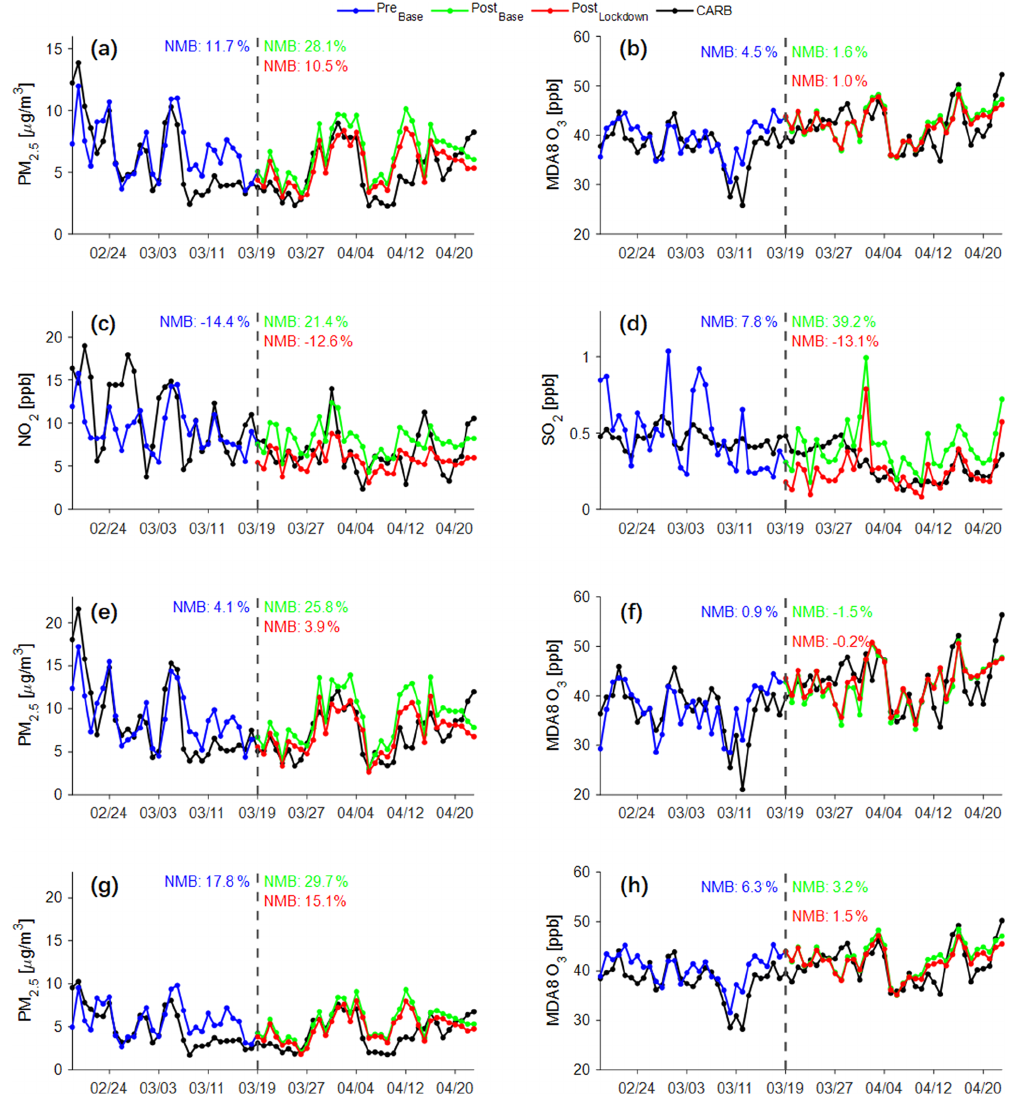
Figure 3. Time series of observed and simulated concentrations of major pollutants. (a–d) Time series of (a) PM 2 . 5 , (b) MDA8 O 3 , (c) NO 2 , and (d) SO 2 averaged across all observational stations from CARB over southern California. (e–f) Time series of (e) PM 2 . 5 and (f) MDA8 O 3 across all stations over the urban areas of southern California. (g–h) The same as (e) – (f) but for the rural areas. Black lines are surface observations from the CARB network. Blue, green, and red lines are simulated air pollutant concentrations during the pre-lockdown period (18 February to 18 March) under the Base scenario (Pre Base ), during the lockdown period (19 March to 23 April) under the Base scenario (Post Base ), and during the lockdown period under the Lockdown scenario (Post Lockdown ). The definitions of the Base and Lockdown sce- ( Var m − Var o )/ (cid:80) N narios are summarized in Table 1. Normalized mean bias (NMB) is given by = (cid:80) N Var o , where N is the number of i = 1 i = 1 sites, and Var m and Var o are modeled and observed concentrations,